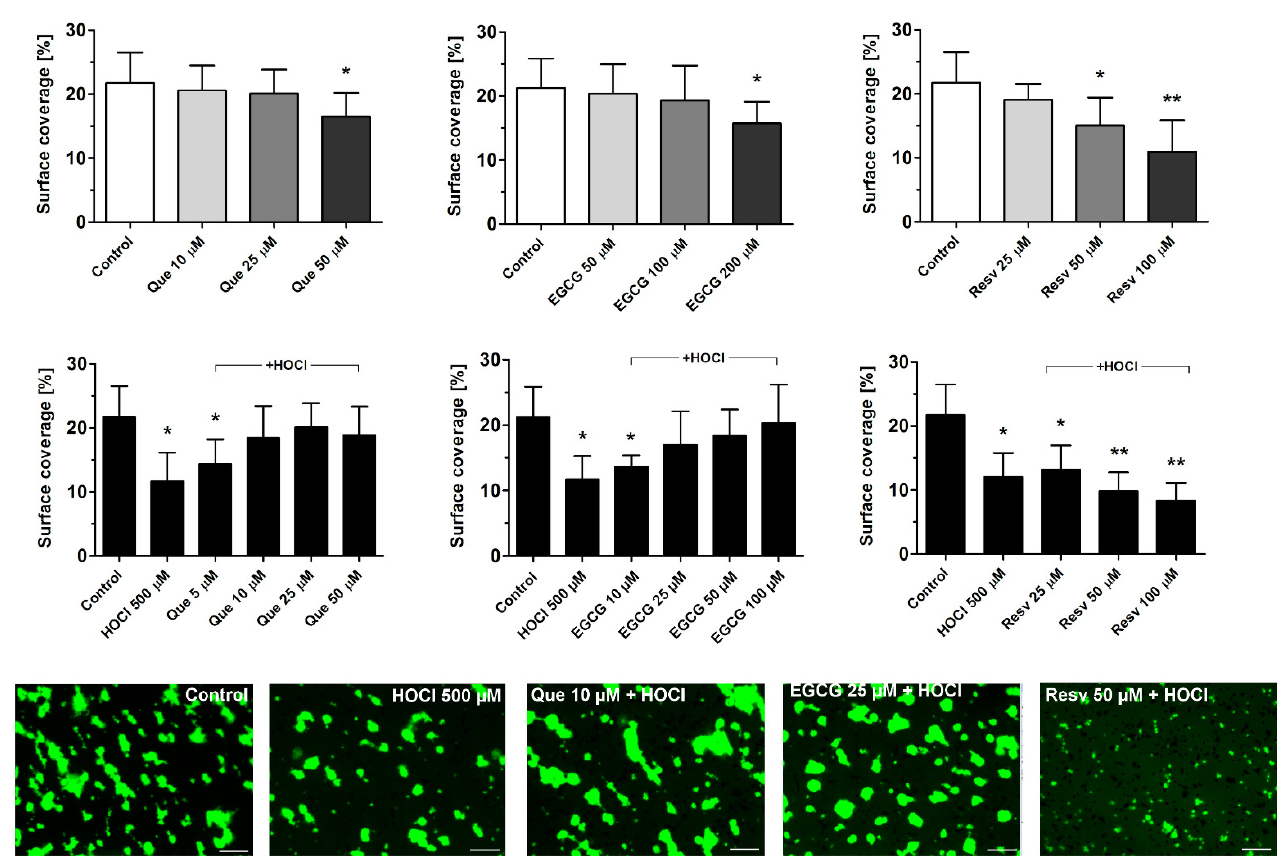
Figure 2. Effects of quercetin, epigallocatechin gallate, and resveratrol on thrombus formation under flow and on HOCl-mediated reduction of thrombus formation. PPACK-anticoagulated whole blood samples (supplemented with DiO to visualize platelets) were incubated with appropriate vehiculum (ethanol or water) or with indicated concentrations of Que, EGCG, or Resv (for 5 min, upper panel ). Next, samples were perfused over collagen-coated surfaces at a shear rate of 1000 s − 1 to form thrombi. Surface coverage area was calculated from end-stage confocal pictures. Lower panel : samples were incubated with HOCl (500 μ M, for 5 min) or with Que, EGCG, or Resv added 1 min before HOCl and thrombus formation was performed under conditions as in upper panel . Representative thrombi obtained in the presence of HOCl or combinations of HOCl with selected concentrations of Que, EGCG, or Resv are presented in lower panel . Data are means ± S.D. from n = 3 experiments. * p < 0.05; ** p < 0.01 vs. control. Distance bar is 10 μ m. Flow direction was from left to right.